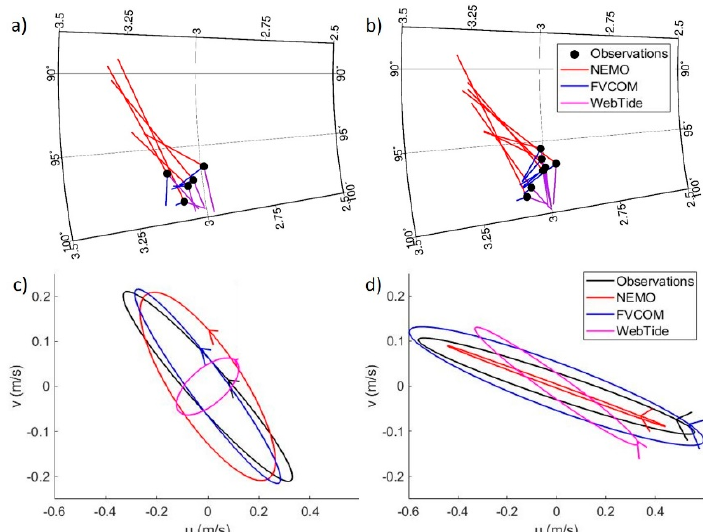
. Figure 3. ( a , b ) Polar plot of the amplitude (m) and phase (degrees) of the observations (black circles) versus the model results in the inner harbour ( a ) and outer harbour ( b ). The size and direction of the vectors (NEMO, red; FVCOM, blue; and WebTide, purple) indicate the difference in the amplitude and phase between the observations and the model. Regional ice-ocean prediction system (RIOPS) results were omitted from these plots. ( c – d ) Observed and modelled M2 tidal ellipses for the surface currents from one station in the inner harbour ( c ) and one in the outer harbour ( d ). Position of the arrow on the ellipse indicates the phase, and the direction of the arrows indicates the counter-clockwise rotation of the complex current. Table 2. The evaluation metrics for the M2 tidal water level and currents (see definitions in Equations (1)–(4) and in the text), averaged for the stations in the inner and outer Saint John Harbour (SJH). Numbers in brackets are the standard deviations across the stations. The metrics are computed for the NEMO, FVCOM, RIOPS and the WebTide solutions, separately. Note that for D and D % , the mean and standard deviations are calculated using the absolute values of the D and D % values at each